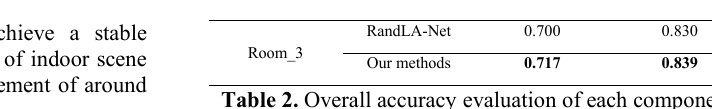
Table 1. Evaluation of the accuracy of the segmentation results of deep learning and the segmentation results.